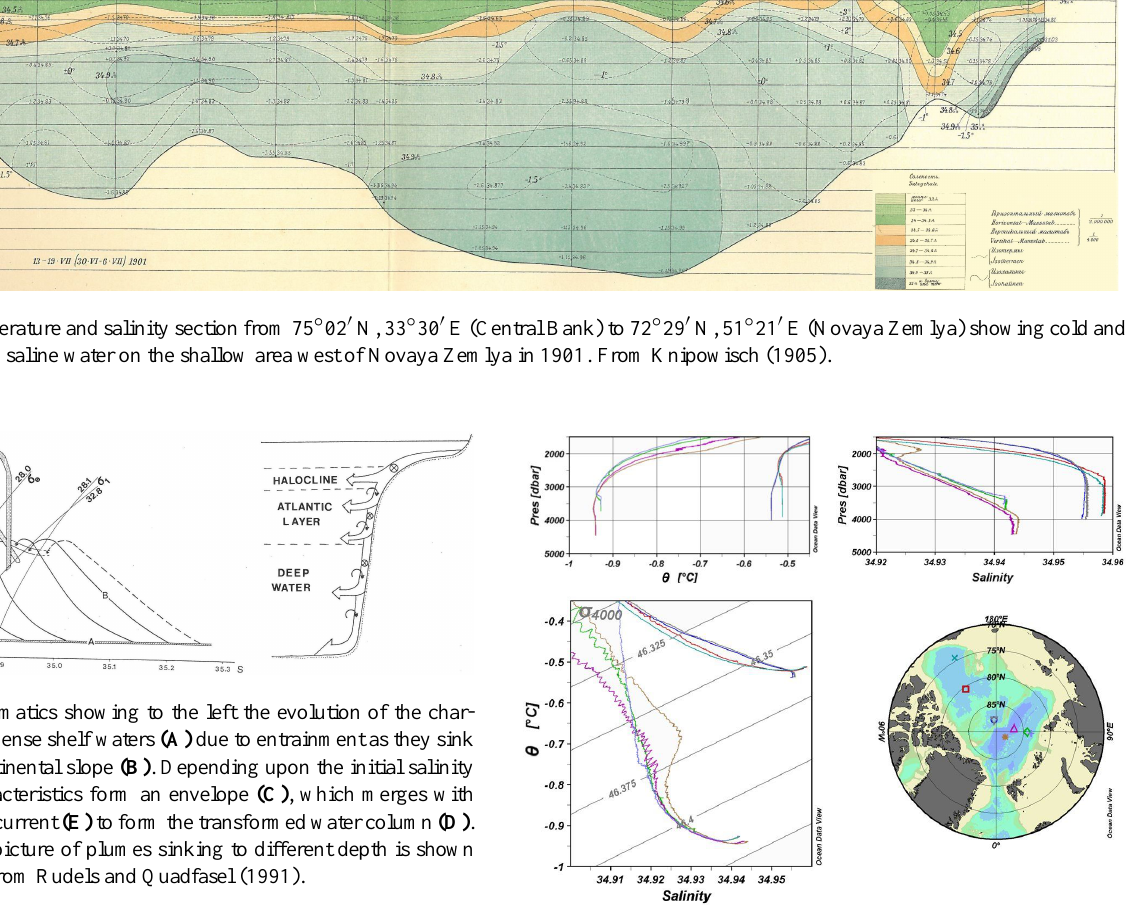
Fig. 17. Deep and bottom water characteristics from the Nansen Basin, Amundsen Basin, Makarov Basin and Canada Basin. Note the absence of a deep temperature minimum in the Makarov Basin and that the temperature minimum observed in the Canada Basin could derive from the Makarov Basin and the deep salinity maxi- mum in the Amundsen Basin could be caused by Makarov Basin deep water crossing the Lomonosov